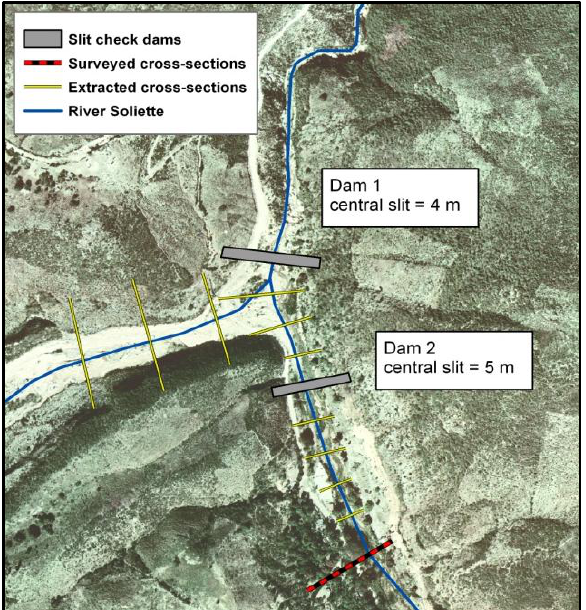
Figure 10. Design check-dams in the lower part of the study area (box ain Figure 1)